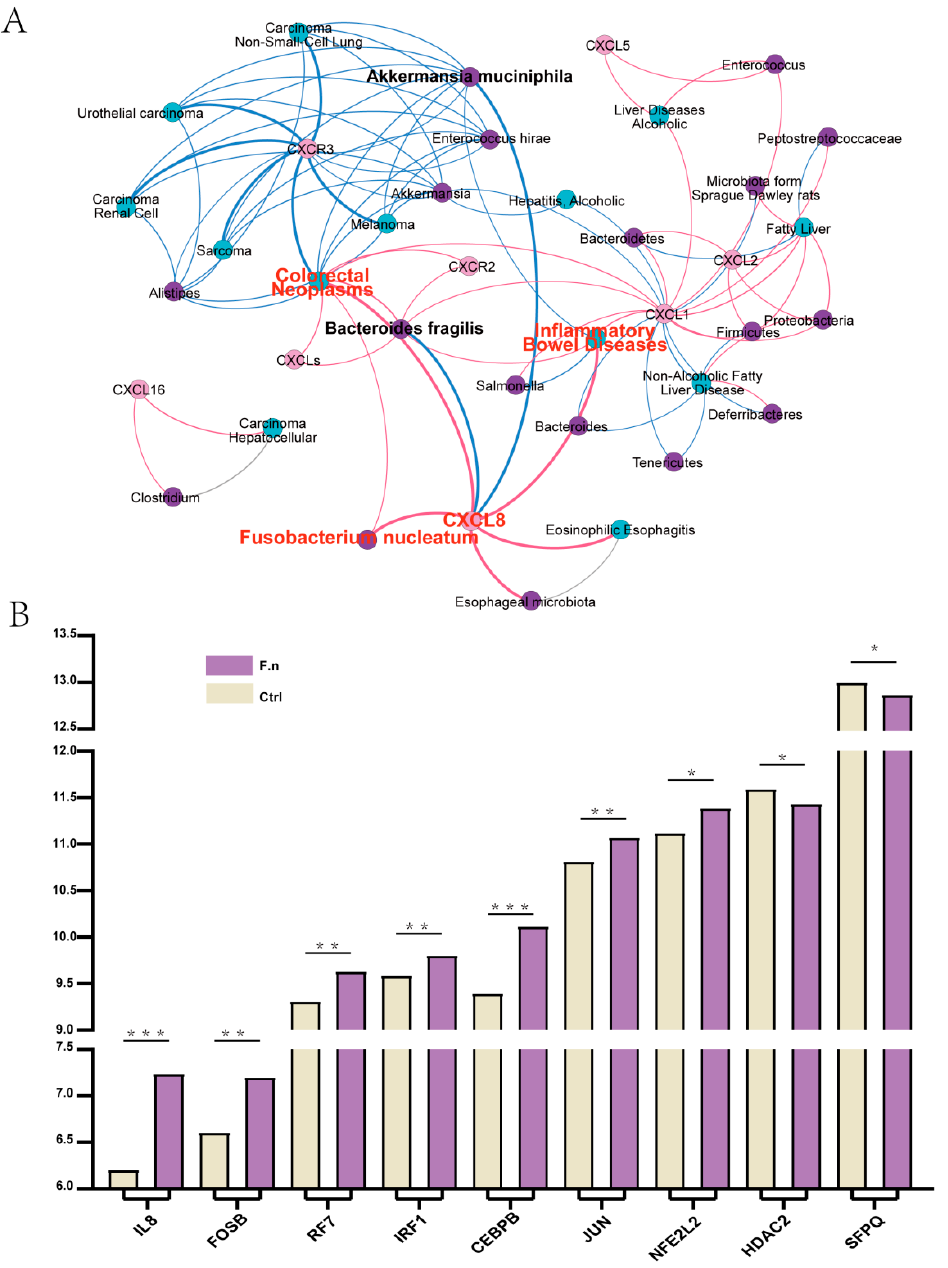
Figure 9. ( A ). Network analysis of CXCs, CXCRs, intestinal flora, and human diseases. ( B ). Expression of CXCL8 and TFs in GSE90944. (* p < 0.05, ** p < 0.01, *** p < 0.001).